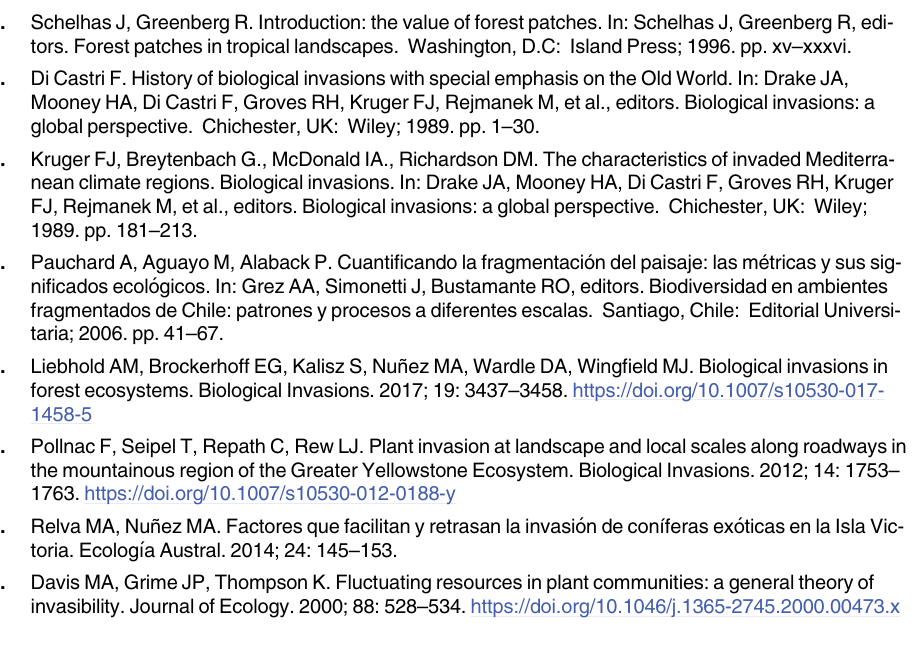
S2 Table. Deviance, AICC values and bootstrap tests for the selection of the best model from hierarchical logistic Huisman-Olff-Fresco (HOF) regression models (Huisman et al. 1993). S3 Table. Summary of original data collected in sampling plots. Latitude and longitude are in